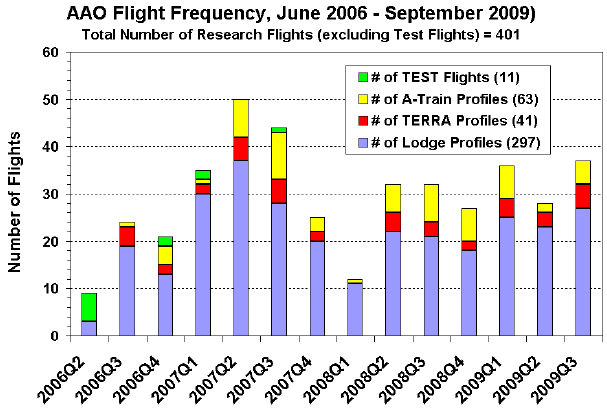
Fig. 5. AAO flight frequency distribution by quarter-year. The routine Lodge and TERRA satellite profiles were all conducted over the Lodge profile location. Each A-Train satellite profile was conducted at one of the three AAO profile locations listed in Table 3.